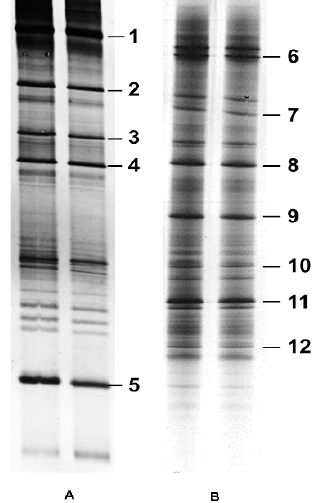
Figure 1. Fungal 18S-ITS fragments obtained from WBPH YLS by DGGE. ( A ) PCR-amplified fragment using the first-round primers NS5-ITS4 and second-round primers GCclampITS1-ITS2. ( B ) PCR-amplified fragment using the first-round primers NS5-ITS4 and second-round primers GCclamp ITS3-ITS4. The corresponding bands were sequenced.